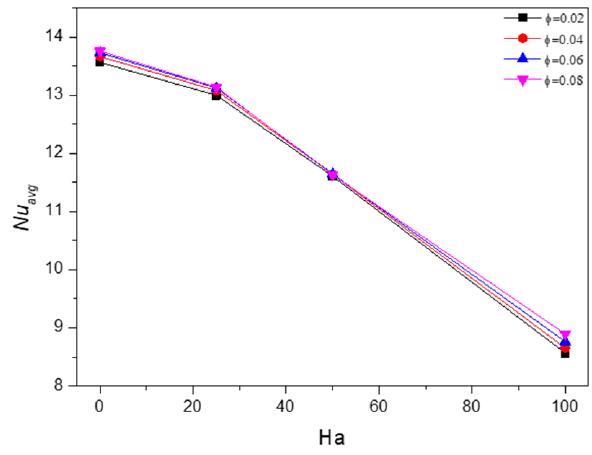
( d ) Ha=100 Figure 16. Variations of the streamlines ( left ), isotherms ( middle ), and general entropy ( right ) with various values of Hartmann number (Ha). 𝜙 = 0.02, Ra=10 6 , Da = 0.01, and 𝜀 = 0.4 . Figures 17–20 provide more insight about the variation of Ha at the higher Ra value of 10 6 and with Da= 0.01. The general conclusion, which was previously drawn earlier, that increasing the value of Ha will dampen the heat transfer, and thus the entropy gen- eration is still applicable. However, it is of interest to know that varying the nano-solid particles volume fraction 𝜙 between 0.02 and 0.08 is not impacting the heat transfer for such Ra and Da at all Ha values (evidenced by Figure 17). In addition, the entropy gener- ation is minimally affected by 𝜙 , where the greatest is at low Ha values, and disappears with higher Ha (Figure 18). Contrary to 𝜙 , the porosity (𝜀 (cid:3043) ) (Figures 19 and 20) affects the heat transfer and total entropy, as concluded before from Figures 6 and 10, respectively. Nonetheless, the new revelation here is the dampening effect of the H a on the improve-